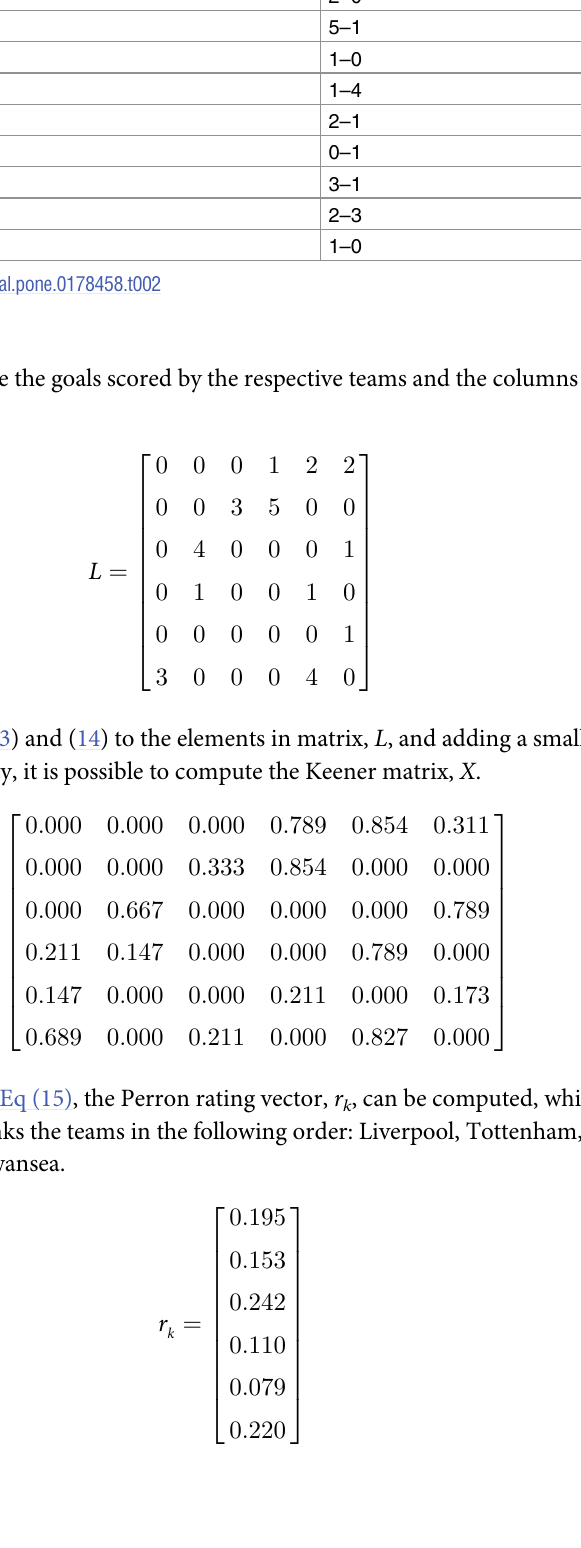
Table 2. The results of matches in the mini- soccer league.